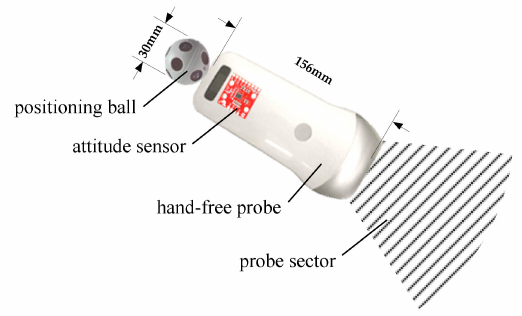
Figure 7. Probe with the attitude sensor and the positioning